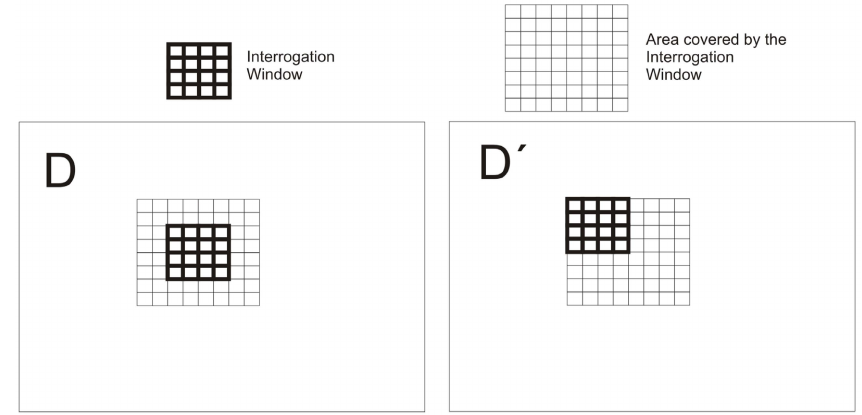
Figure 5. Interrogation window on the first DEM (D) and a displacement over the homologous DEM (D 1 ).